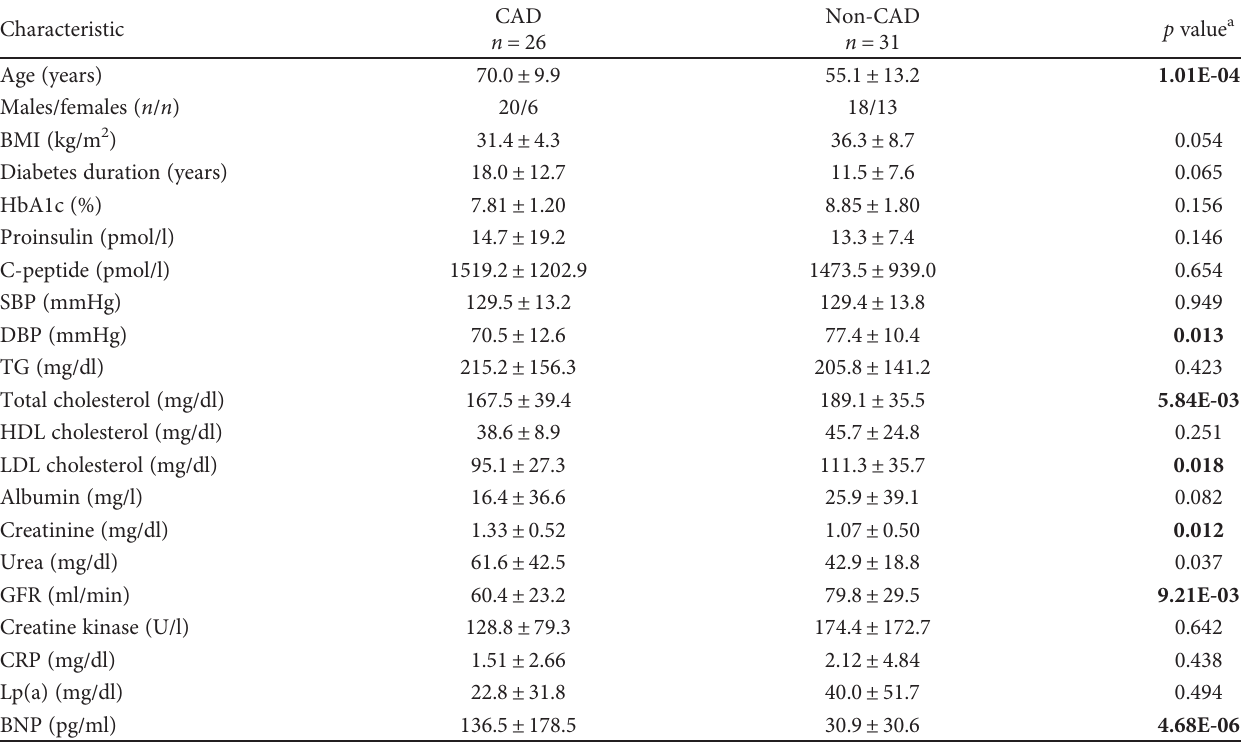
Table 1: Characteristics in patients with T2D under antidiabetic therapy (strati fi ed by CAD status; CAD=cases, non-CAD=controls).